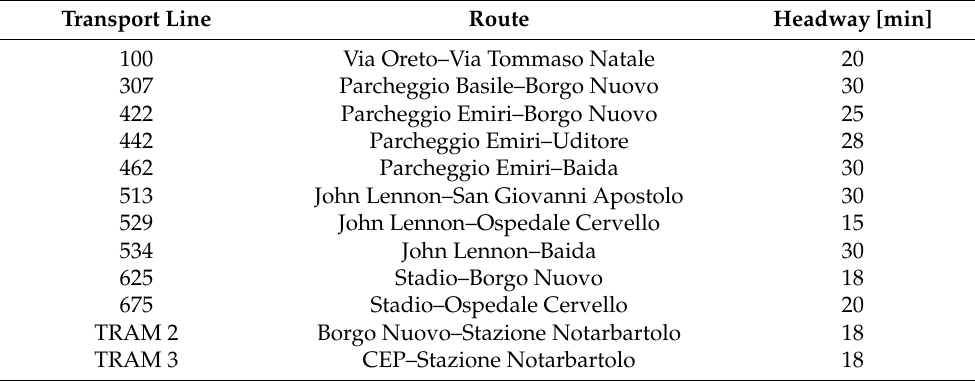
Table 1. Transport lines, routes and headways of public transport services within the study area.